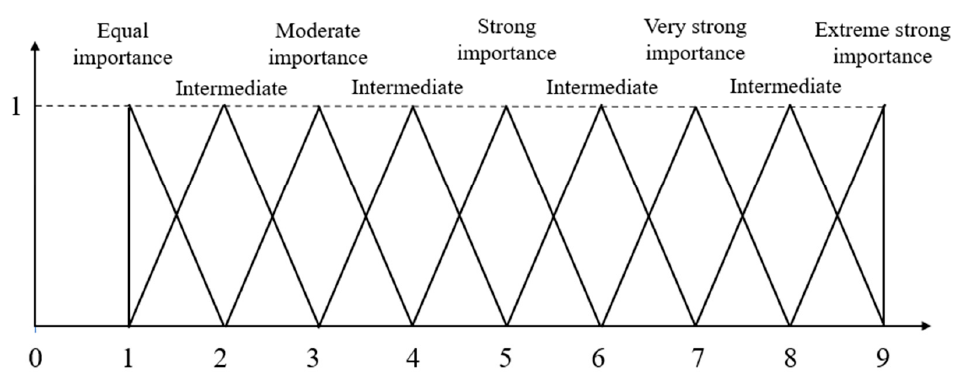
Figure 2. Degree of influence and corresponding TFNs for expert assessment.